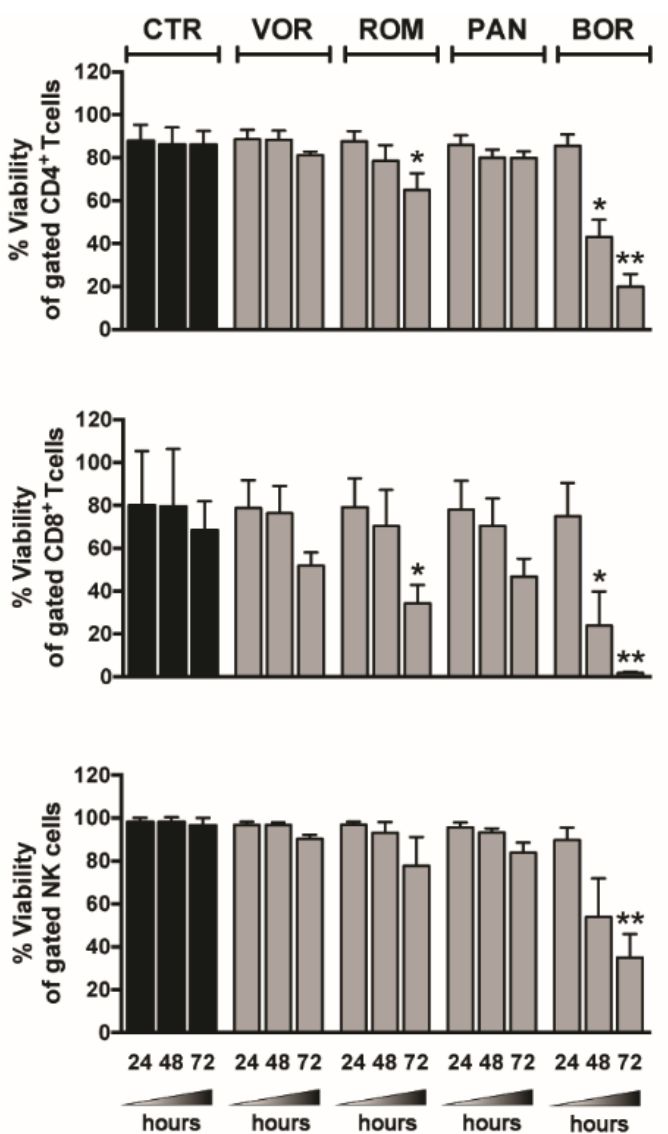
Figure 2. Lymphocyte viability in LRA-treated PBMCs. PBMCs were cultured in medium alone (control, CTR) or supplemented with 334 nM VOR, 10 nM ROM, 20 nM PAN, 5 nM BOR; after 24, 48, and 72 h, the viability of CD4 + T (top), CD8 + T (center), and NK cells (bottom) was examined by LIVE/DEAD staining and flow cytometry analysis of gated CD3 + CD4 + , CD3 + CD8 + , and CD3 − CD56 + CD16 +/ − cells, respectively. Bars represent mean ± SEM ( n = 4). * p < 0.05, ** p < 0.01 by paired t -test.